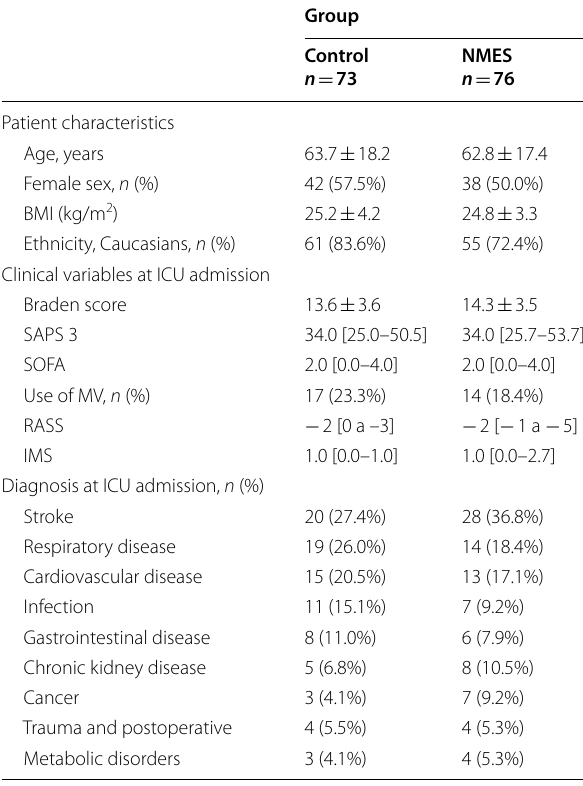
Table 1 Baseline characteristics